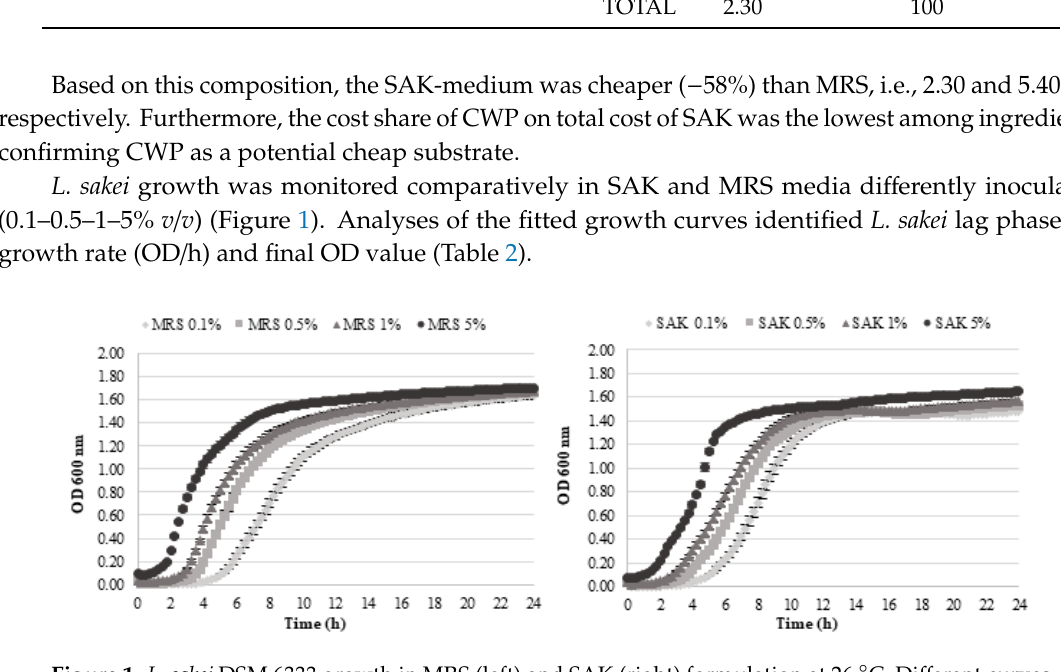
Figure 1. L. sakei DSM 6333 growth in MRS (left) and SAK (right) formulation at 26 °C. Different curves correspond to different percentage of inoculum ( v / v ), from 0.1% (light grey) to 5% (black).